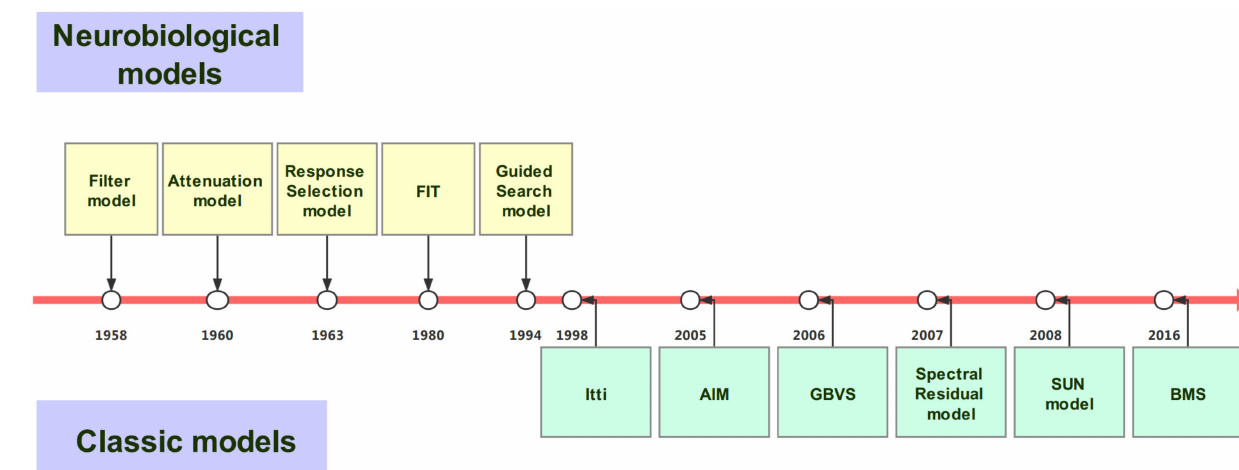
Figure 2. Development process of neurobiological models and classic